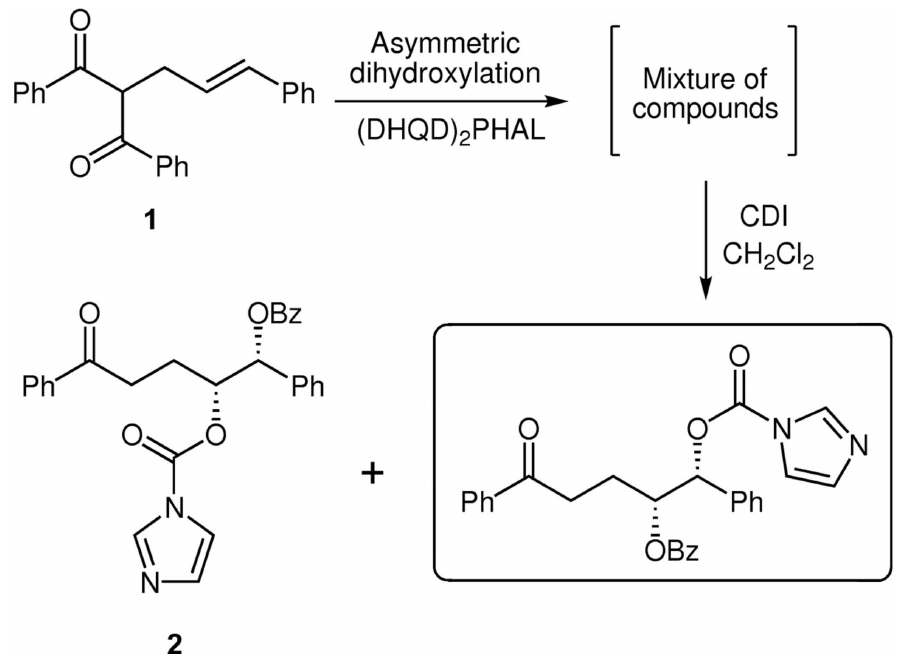
PHAL = Hydroquinidine 1,4- 2